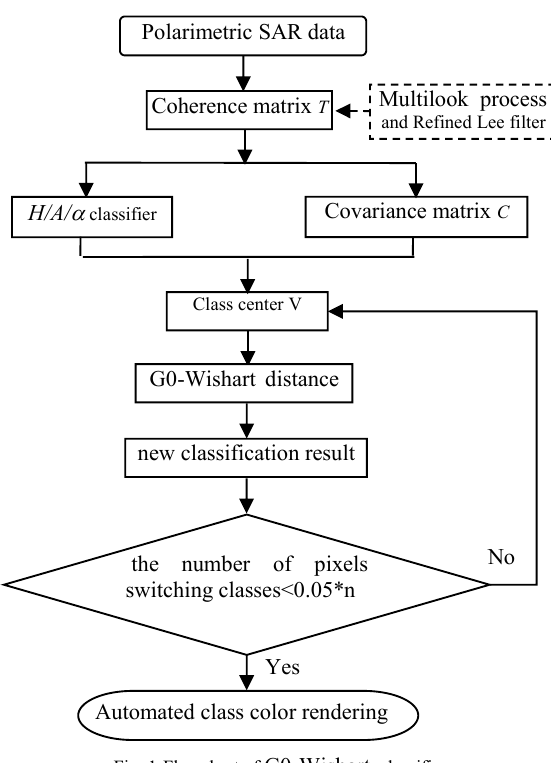
Fig. 1 Flowchart of G0-Wishart